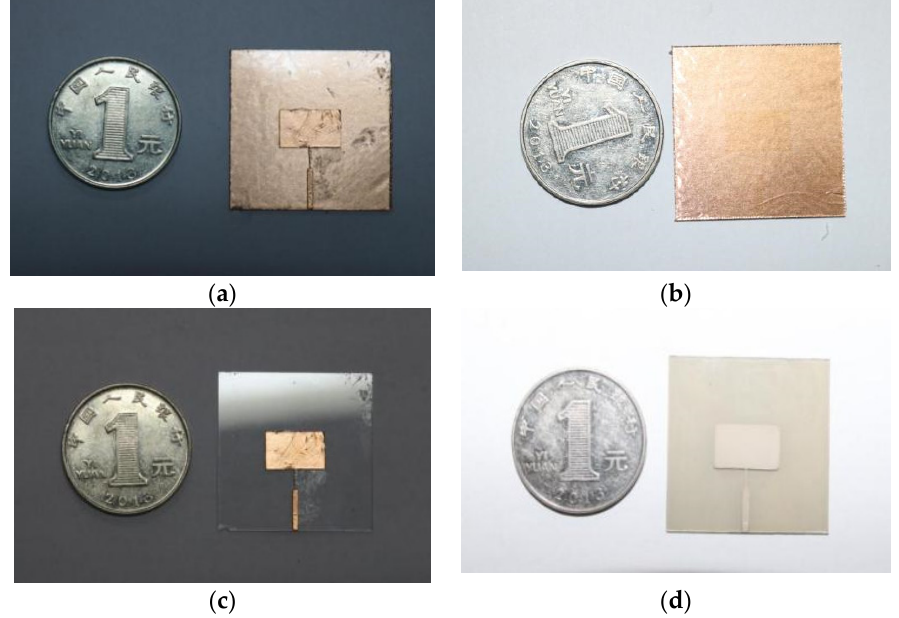
Figure 2. The photo of the fabricated glass antennas presented in Table 2. ( a ) Case 1. ( b ) Case 2. ( c ) Case 3. ( d ) Case 4.